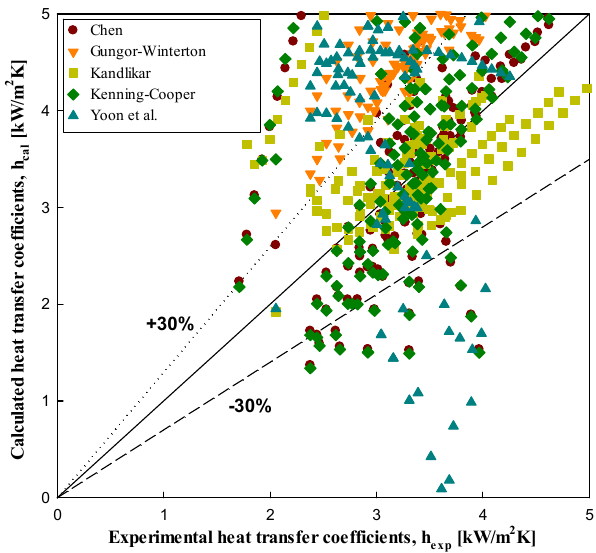
Figure 11. Comparison of the heat transfer coefficient calculated using existing correlations and the experimental heat transfer coefficient for all data.